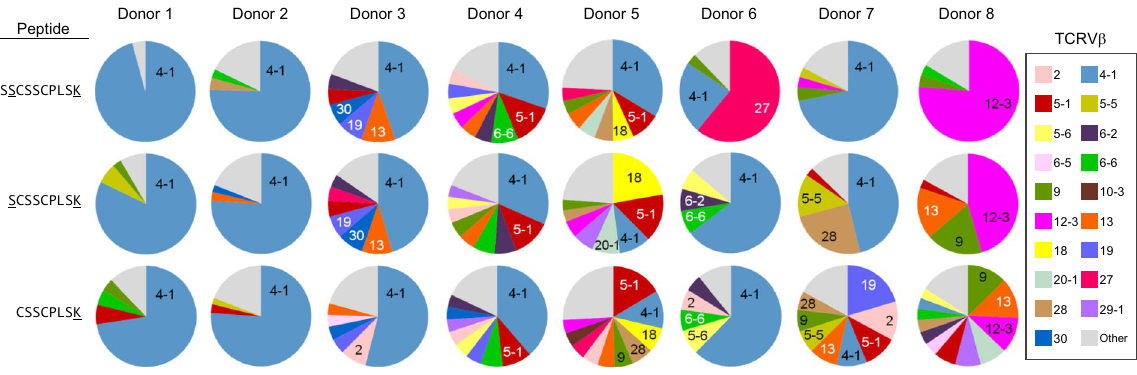
Figure 2. TCRV β usage in CD8 and tetramer double-positive T cells from A * 11:01 donors following different peptide stimulation. T-cell receptor V β (TCRV β ) usage in A * 11:01/SSCSSCPLSK tetramer positive T cells stimulated with different lengths of SSCSSCPLSK peptide in 14-day culture of PBMCs from eight HLA-A * 11:01 positive